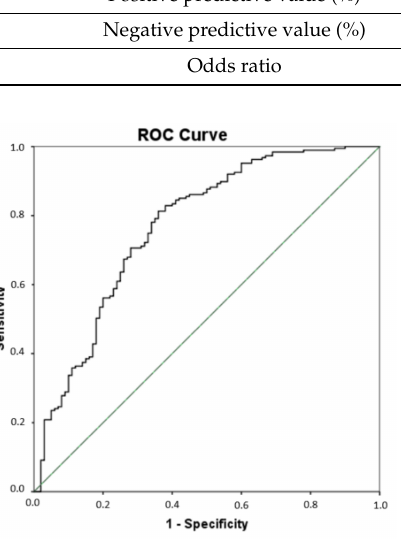
Figure 2. Receiveroperatingcharacteristic(ROC)curveforthedifferentialdiagnosisofADdevelopedfrom the multivariate PLS model. The area under curve (AUC) is 0.77 (95% Confidence interval (CI), 0.71–0.83). Table 6. Lipid peroxidation compounds in AD prognosis